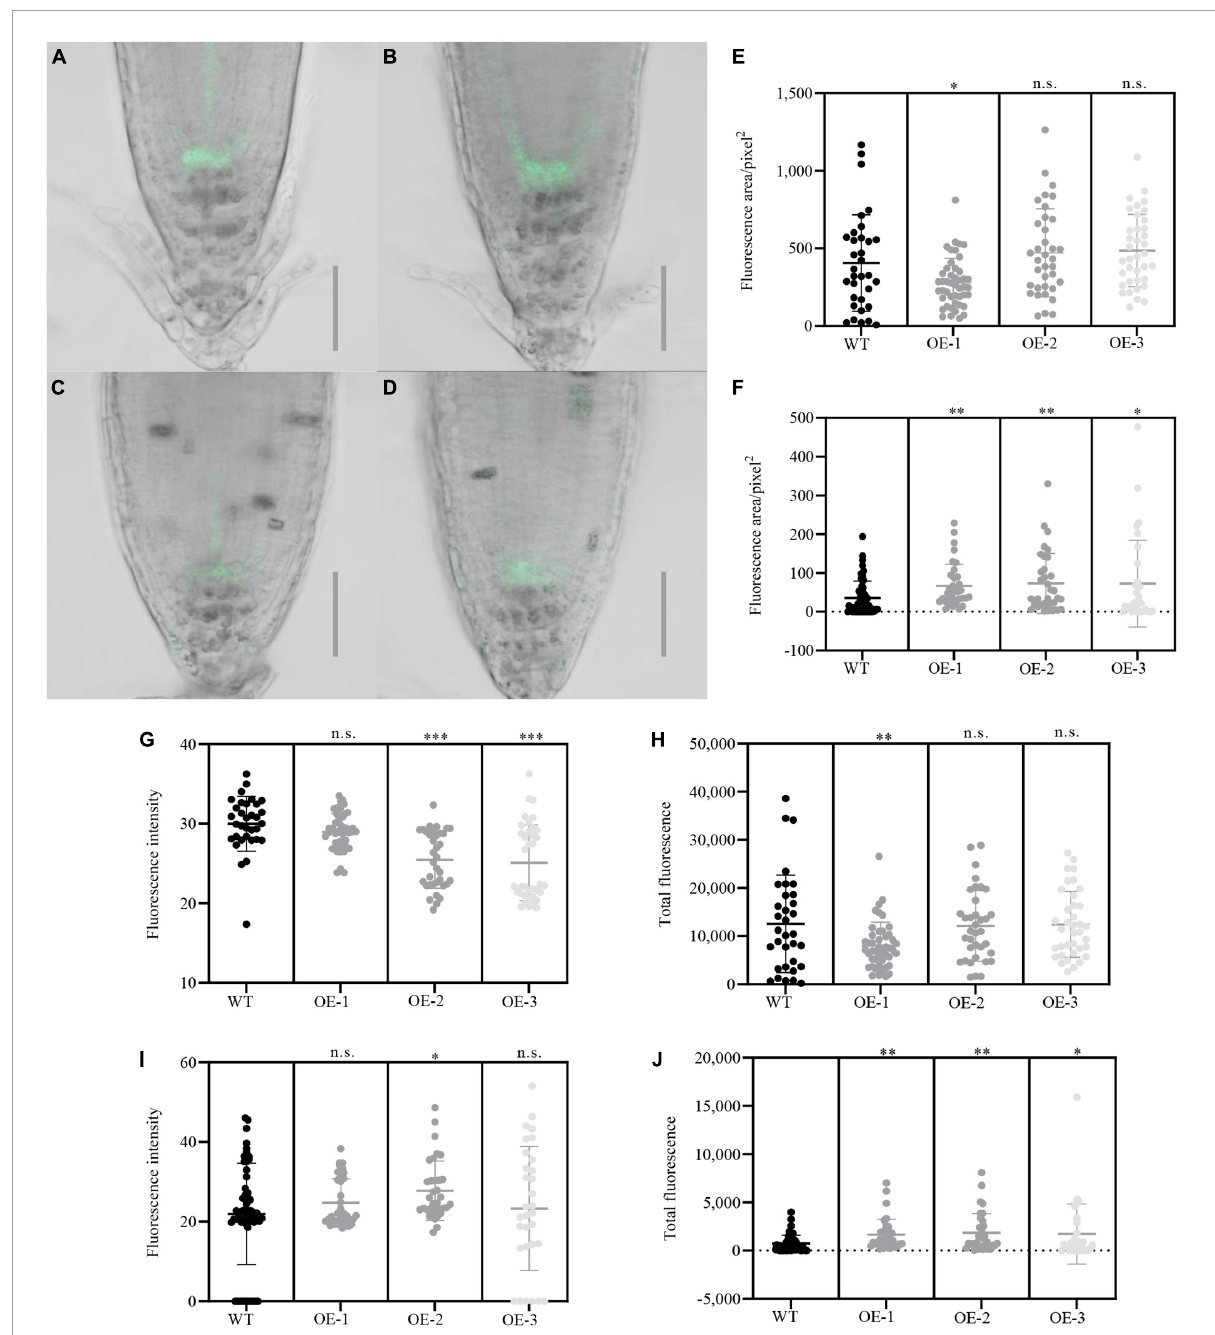
FIGURE6 NbCIPK25 affects the activity of root meristem cells under salt stress. (A–D) Green fluorescence indicates the J2341:GFP signal in WT (A) and transgenic seedlings (B) treated with 0 mM NaCl for 24 h; J2341:GFP in WT (C) , and transgenic seedlings (D) treated with 100 mM NaCl for 24 h; scale bar: 50 µ m. (E–J) Fluorescence area (E) , fluorescence intensity (G) , and total fluorescence (H) of the J2341:GFP signal in the 5-day-old WT and transgenic seedlings treated with 0 mM NaCl for 24 h; Fluorescence area (F) , fluorescence intensity (I) , and total fluorescence (J) of J2341:GFP signal in the 5-day-old WT and transgenic seedlings treated with 100 mM NaCl for 24 h; Data represent means ± SD from three biological replicates. “ ∗ ” p < 0.05; “ ∗∗ ” p < 0.01; “ ∗∗∗ ” p < 0.001; n.s. means no significant difference based on an unpaired t